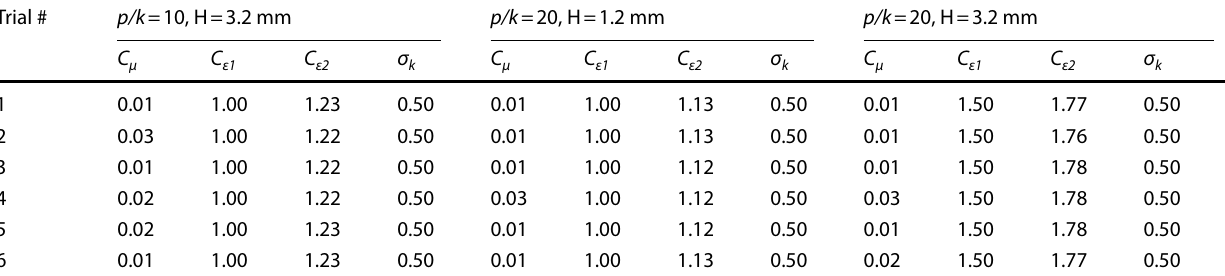
Table 10 Calibrated values of turbulence model parameters obtained from GA-based simulations with 0.5 crossover and mutation rates 0.5 and 0.05